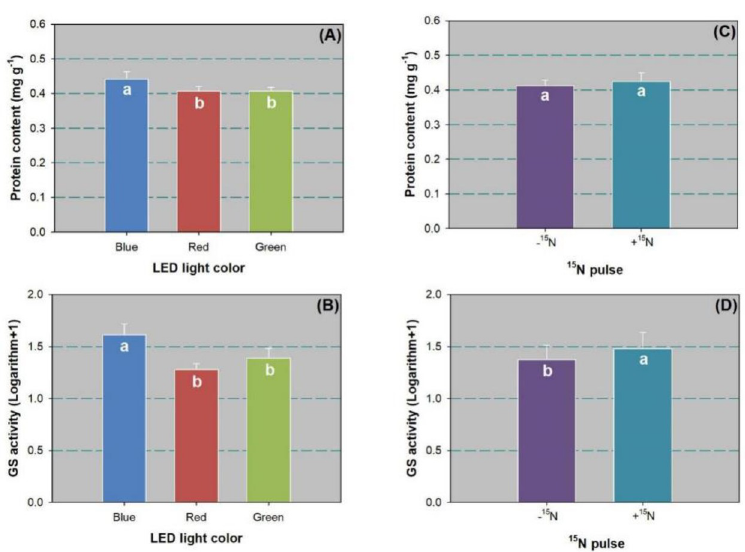
Fig 3. Soluble protein content (A,C) and glutamine synthetase (GS) activity (B,D) in leaves of Chinese cork oak ( Quercus variabilis Blume) seedlings subjected to blue, red, and green LED spectra lighting ( n = 24) or subjected to N pulse at 120 mg 15 N plant -1 (+ 15 N) or zero (- 15 N) ( n = 36). Data that failed to follow a normal distribution were transformed by logarithm plus 1.0. Columns and bars represent means and standard errors, respectively. Different letters mark significant difference according to Tukey’s test at the 0.05